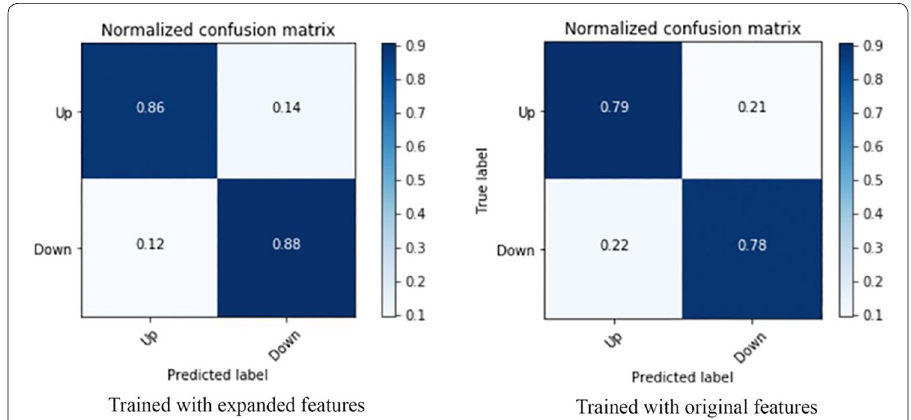
Fig. 5 Confusion matrix of validating feature extension effectiveness